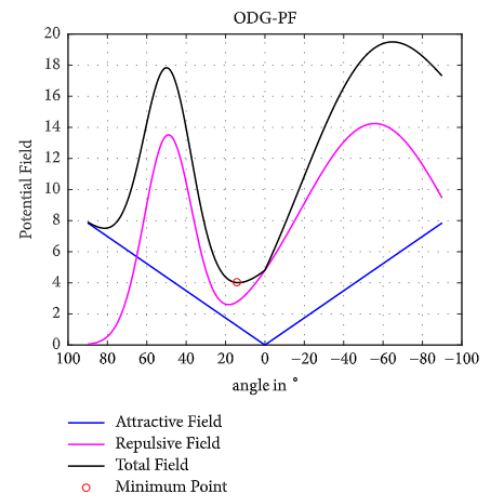
Figure 5. Result of obstacle-dependent Gaussian (ODG) potential field (PF).